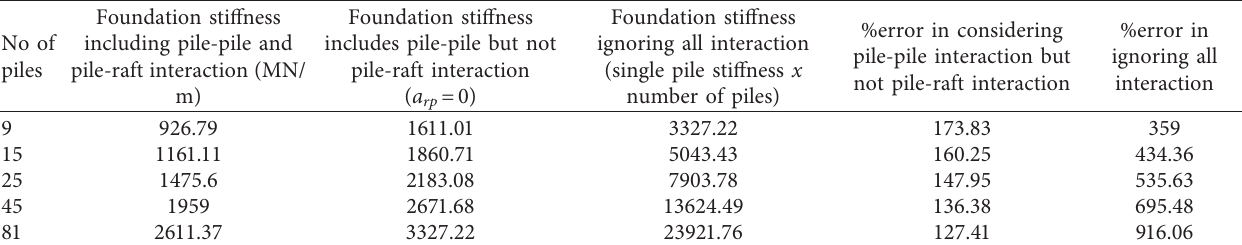
Table 9: Comparison of combined piled raft stiffness ignoring interaction factor.